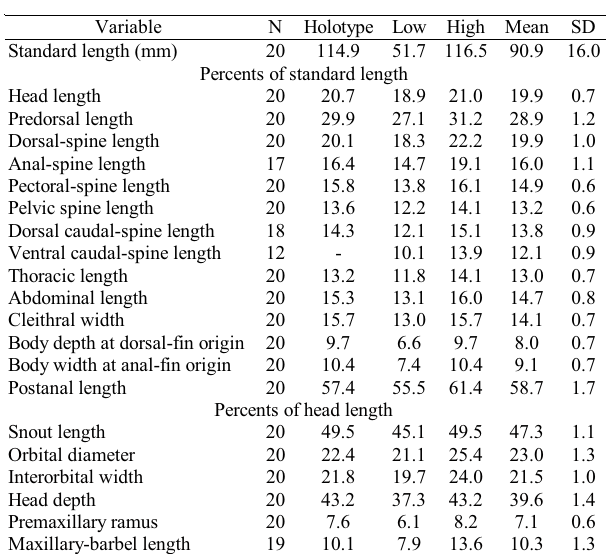
Table 1. Morphometric data of Rineloricaria langei from upper rio Iguaçu. N = sample size; SD = Standard deviation. Range includes